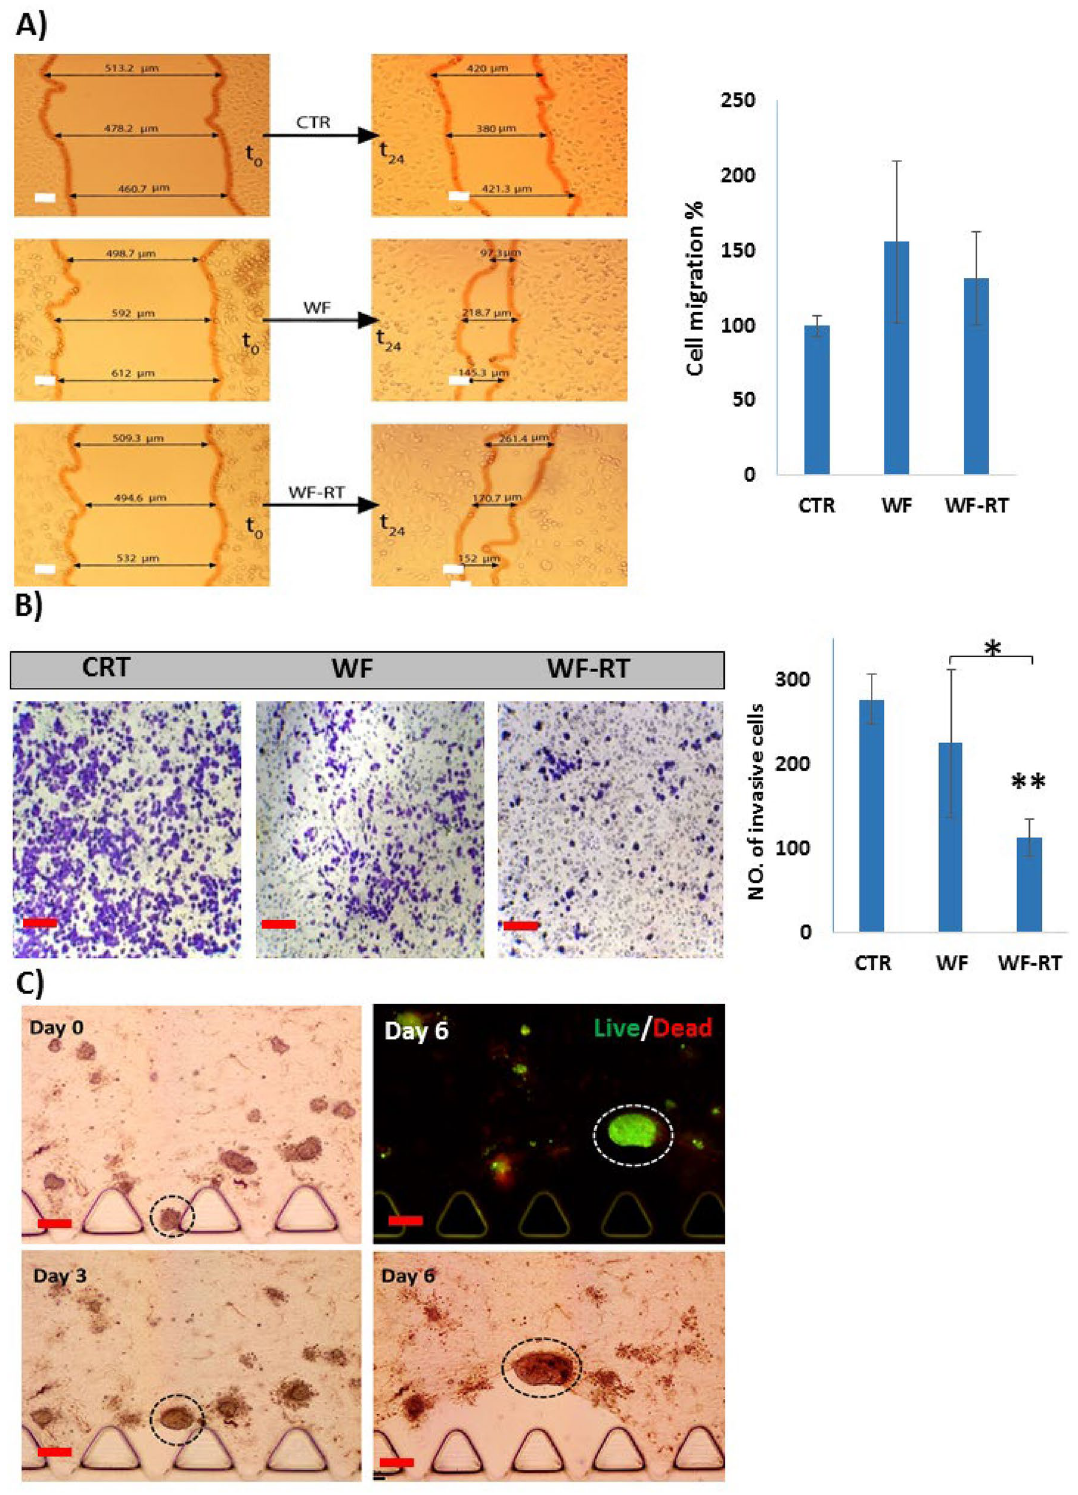
Figure 7. Effects of WFs on migration and invasion BC cell line (MDA-MB 231) and in human-derived tumor spheroids. ( A ) Images and graphs related to scratch assay (wound healing compared to negative control in 0 and 24 h). The graph presents the percentage of migrated cells. ( B ) Images of the cells on the upper chamber in transwell assay and graph present the percentage of cell migration. *P < 0.05, and **P < 0.01. ( C ) Migration of BC tumor spheroids in microfluidic devices. Circular dotted lines show one of the spheroids that migrate during 6 days of incubation with WF. Scale bars: 100 µm. Original magnifications: